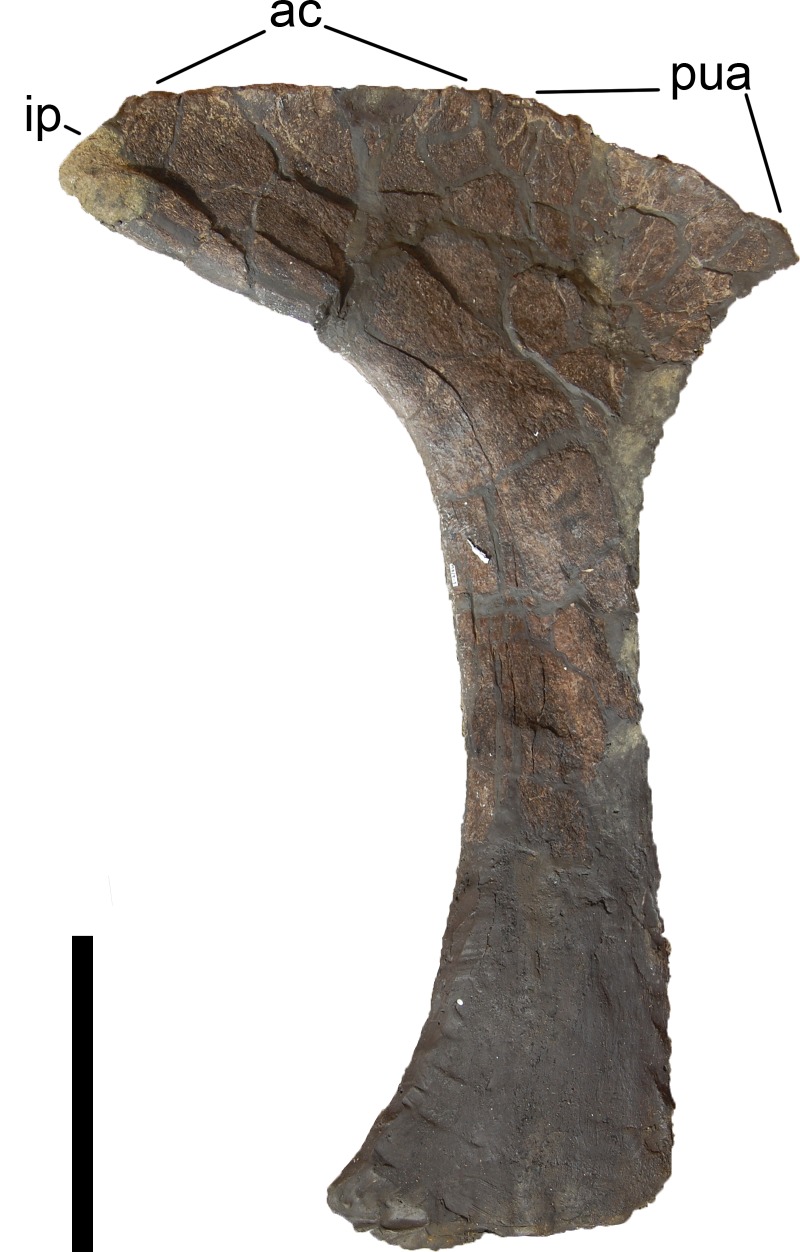
Left ischium of Galeamopus pabsti SMA 0011 in medial view.The distal end of the ischium is reconstructed. Abb.: ac, acetabular surface; ip, iliac peduncle; pua, pubic articular surface. Scale bar = 20 cm.